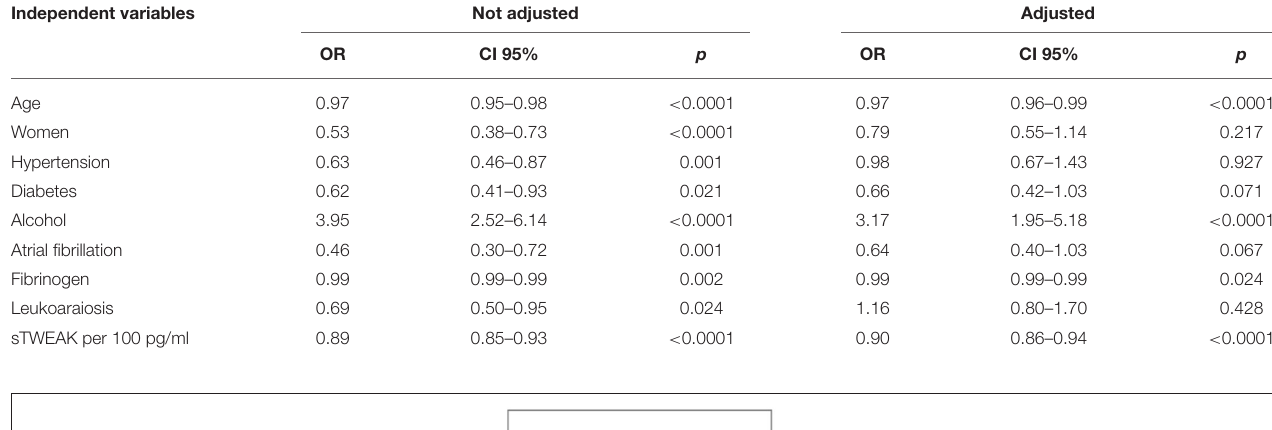
TABLE 2 | Logistic regression models for factors associated with smoking habit. Independent variables